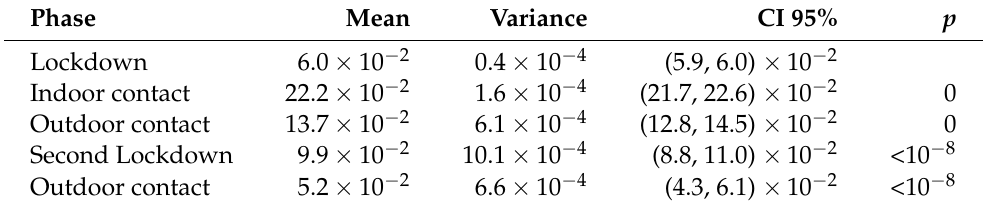
Figure 17. Histogram of the 33 different regions of Germany. The value of β E at the different levels of lockdown registered in 2020. Table 10. Histogram for the mean values of β E at the different stages of lockdown in